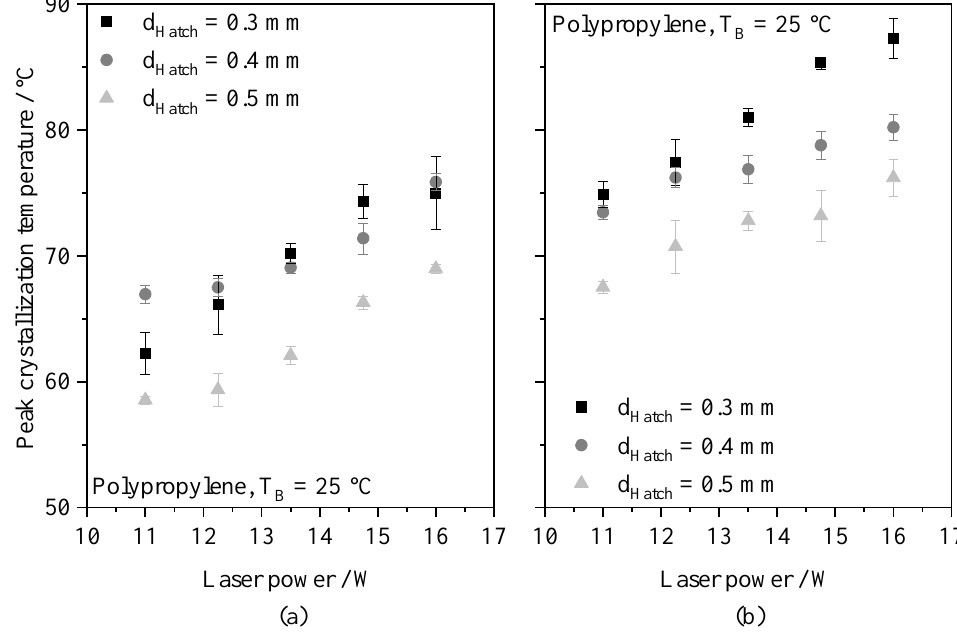
Figure 6. Influence of varying processing parameters on corresponding peak crystallization temperatures observed during the initial ( a ) and the second ( b ) exposure cycle.